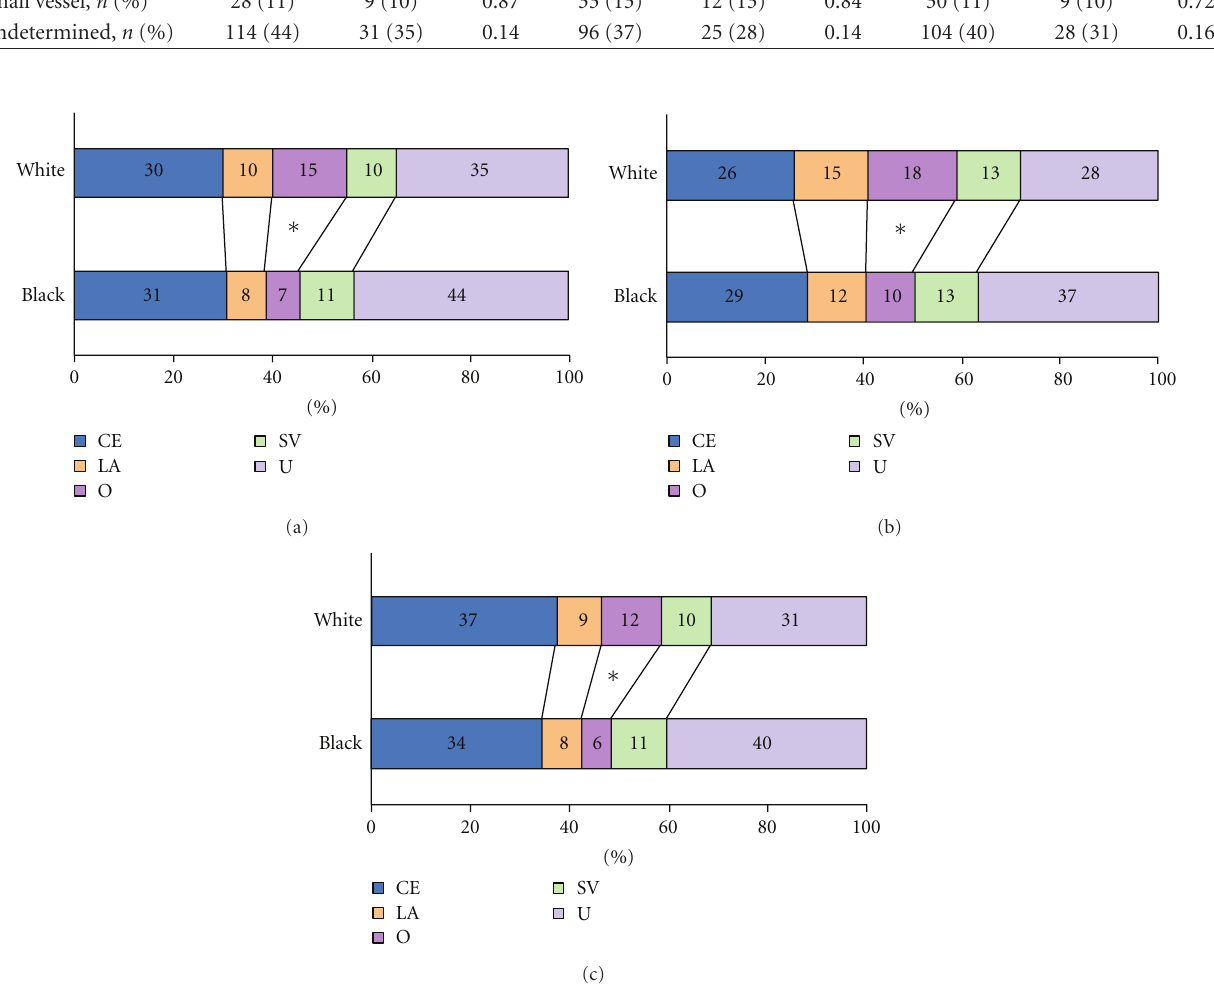
Figure 1: Proportions of stroke subtype by race for each classification system ( ∗ indicates statistical significance at a P < 0 . 05). (a) Standard TOAST. (b) SSS-TOAST. (c) Imaging